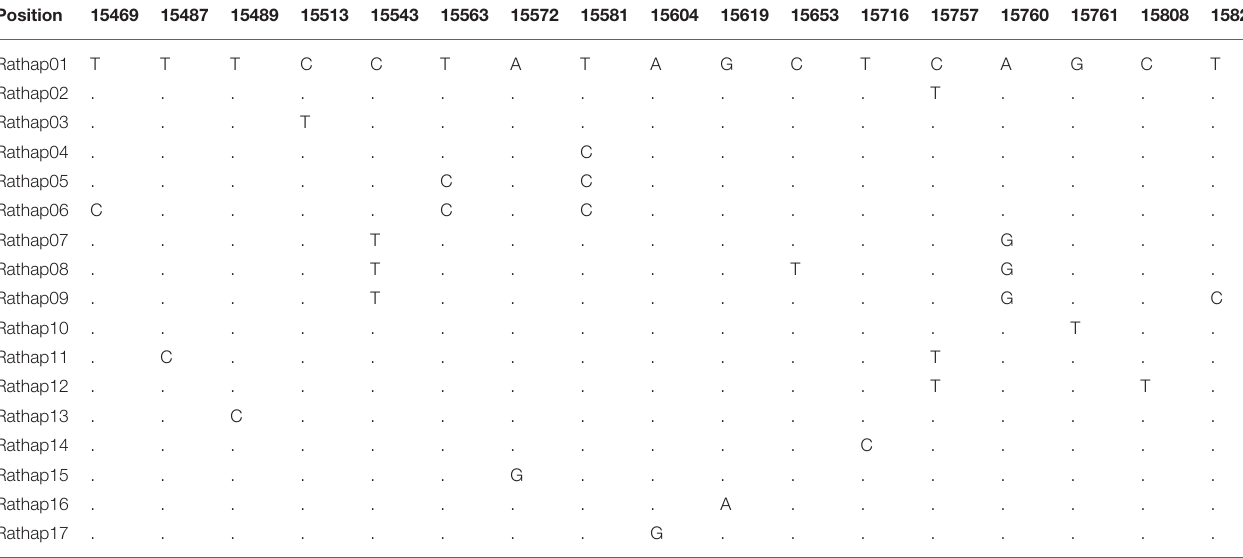
TABLE 3 | Differences in the base composition of R. rattus haplotypes from across the New Zealand archipelago. Position